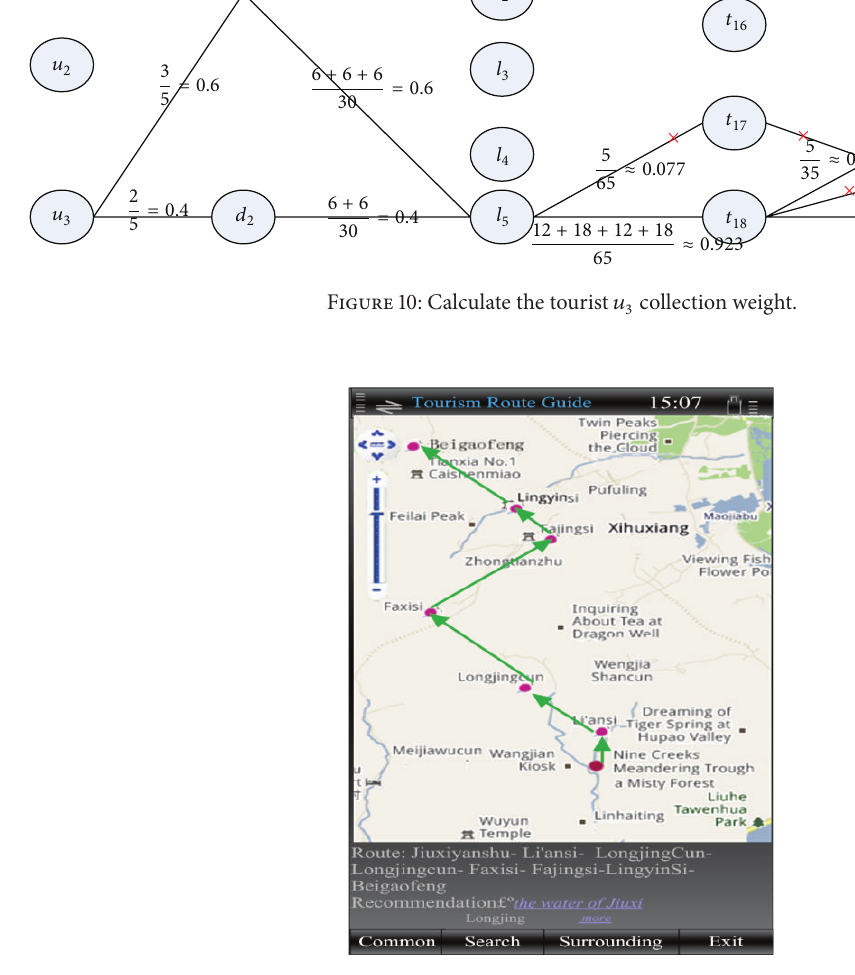
Figure 11: Tourism route